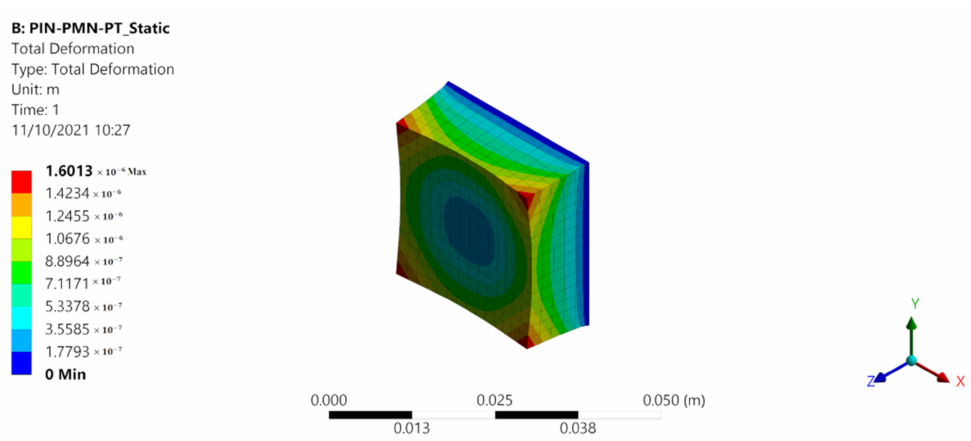
Figure 7. PIN24%-PMN-PT plate static analysis result using Method